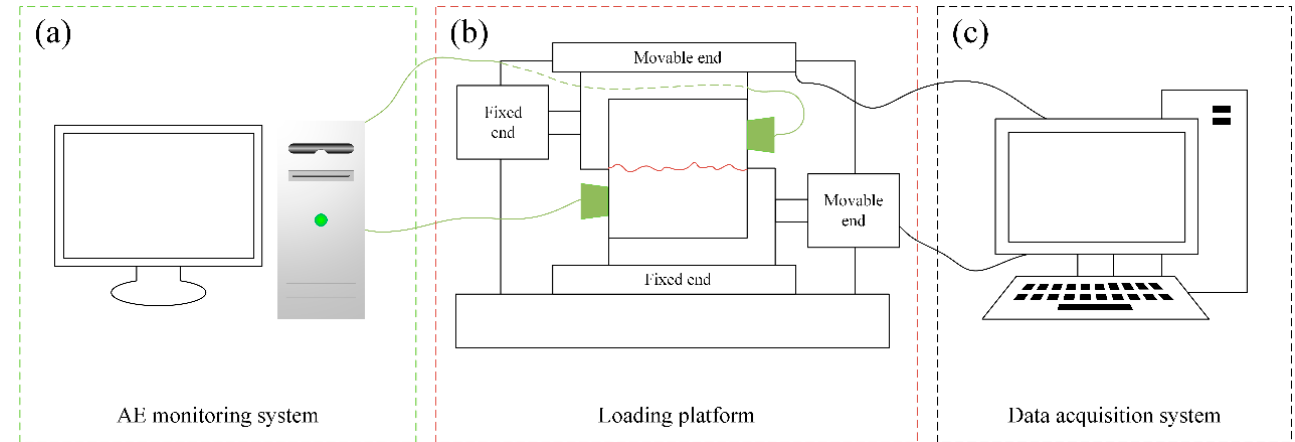
Figure 5. The arrangement of experimental devices. ( a ) AE monitoring system ( b ) Loading platform ( c ) Data acquisition system.